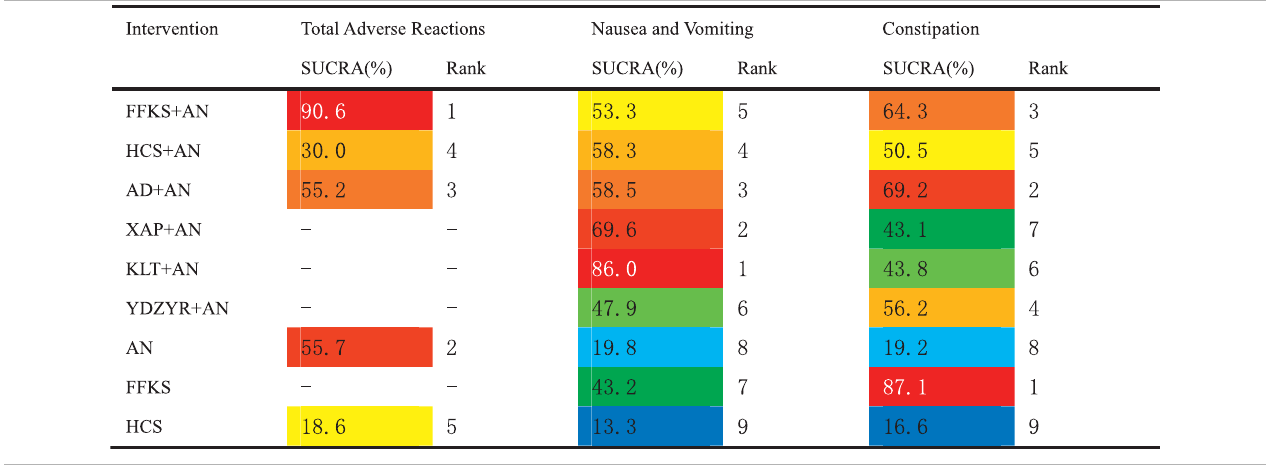
TABLE 5 | Surface under the cumulative ranking probabilities (SUCRA) results of safety outcomes.